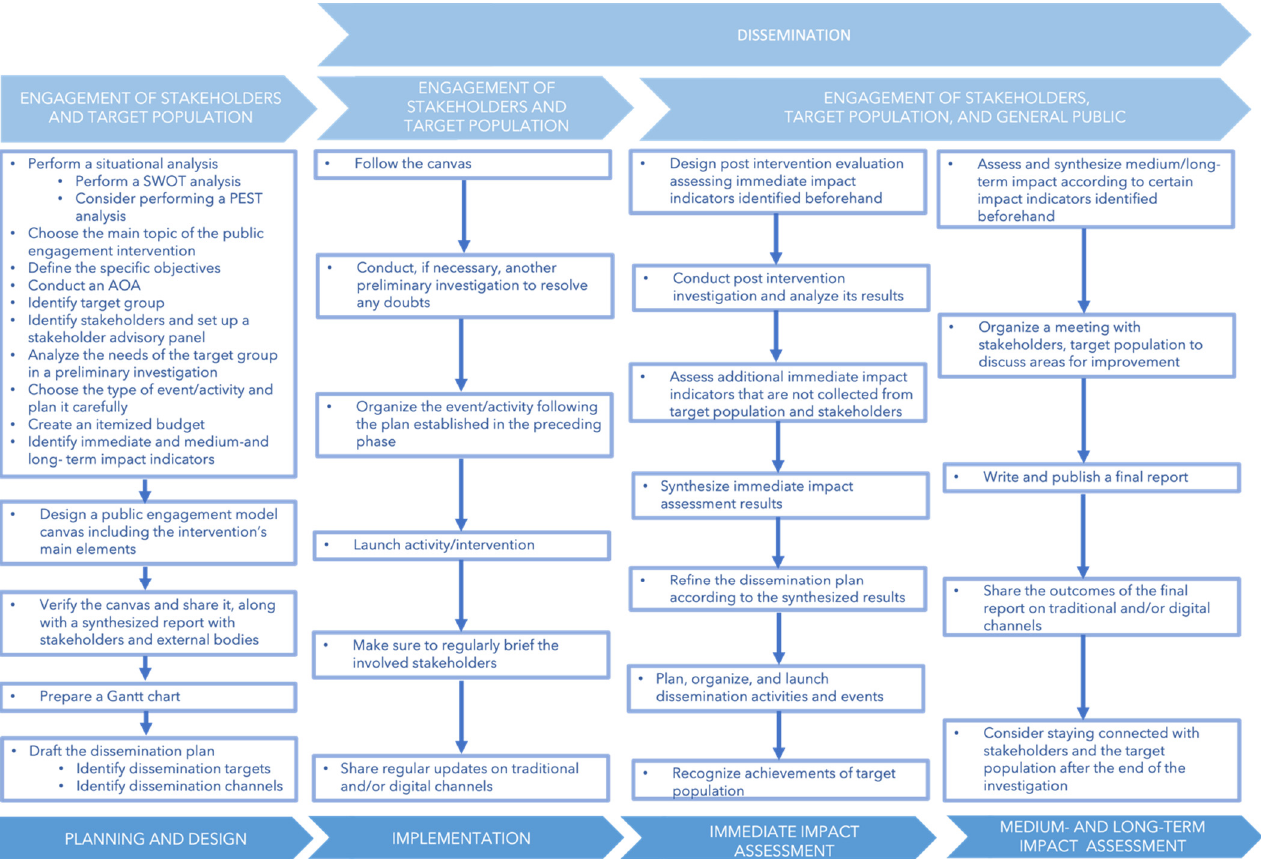
Figure 2. Framework for public engagement interventions. Abbreviations: AOA, analysis of alter- natives; PEST, political, economic, socio-cultural, and technological changes; SWOT, strengths, weaknesses, opportunities, and threats.